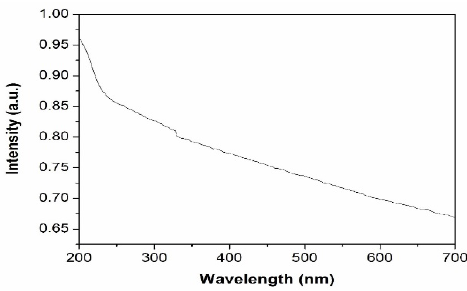
Figure 6. Plot of ( α h ν ) 2 vs. h ν of Al 2 O 3 nanoparticles.